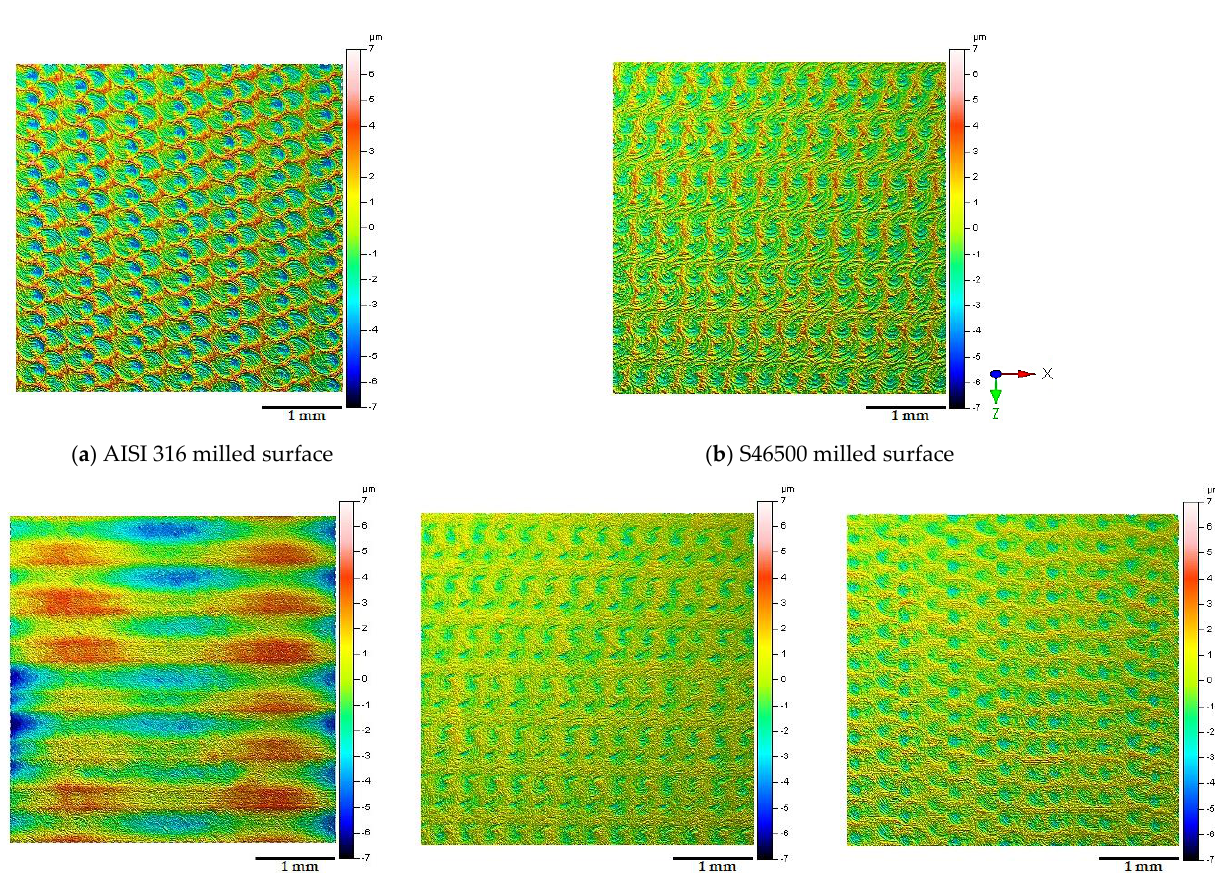
Figure 5. Textured surfaces after milling and burnishing processes at different contact pressures.